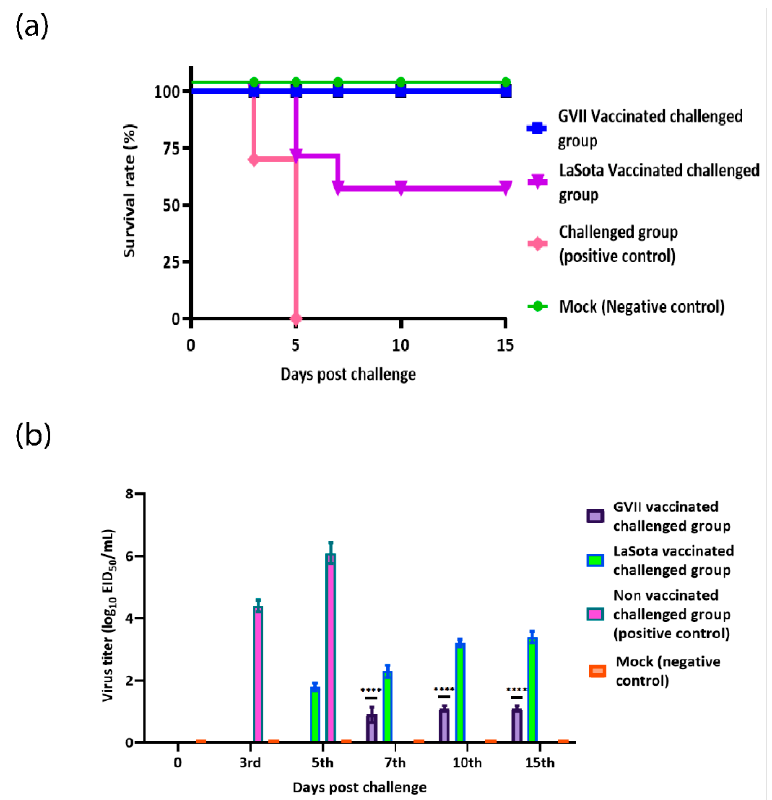
Figure 6. Survival rates and Evaluation of viral shedding. ( a ) Percentage survival rates and ( b ) Viral shedding from oropharyngeal swabs of genotype VII.1.1 and LaSota vaccinated challenged chicks with virulent NDV compared to negative and positive control groups. Bars represent the standard deviation means. **** indicates the level of significance at p value < 0.05.